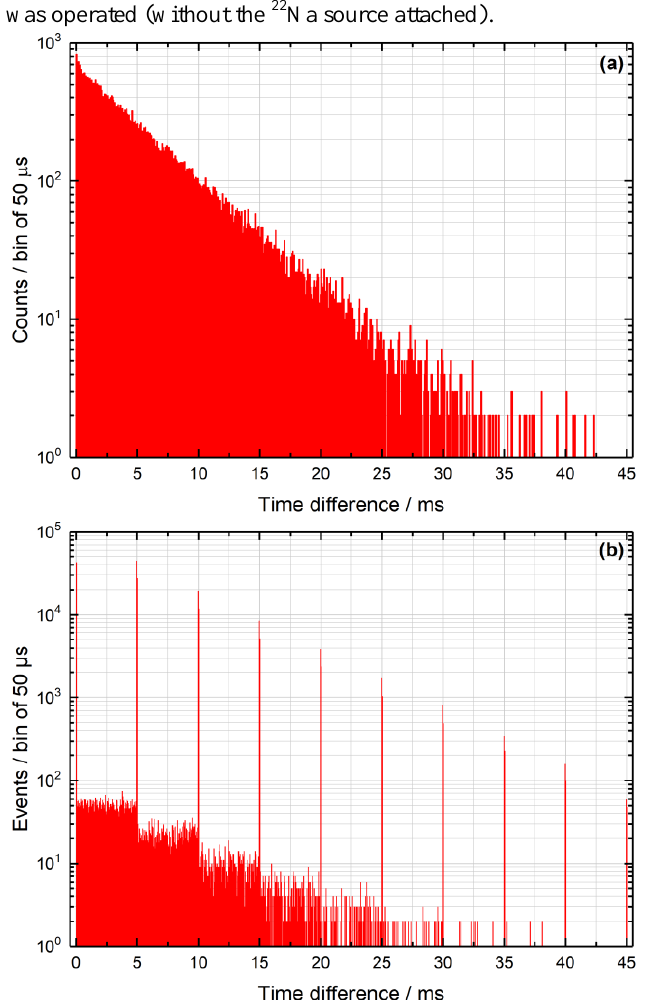
Fig. 3. Time difference histograms for the case when the 22 Na source only was used (a) and when the accelerator was switched on and no 22 Na (b). The accelerator current in (b) was of 25 μA.